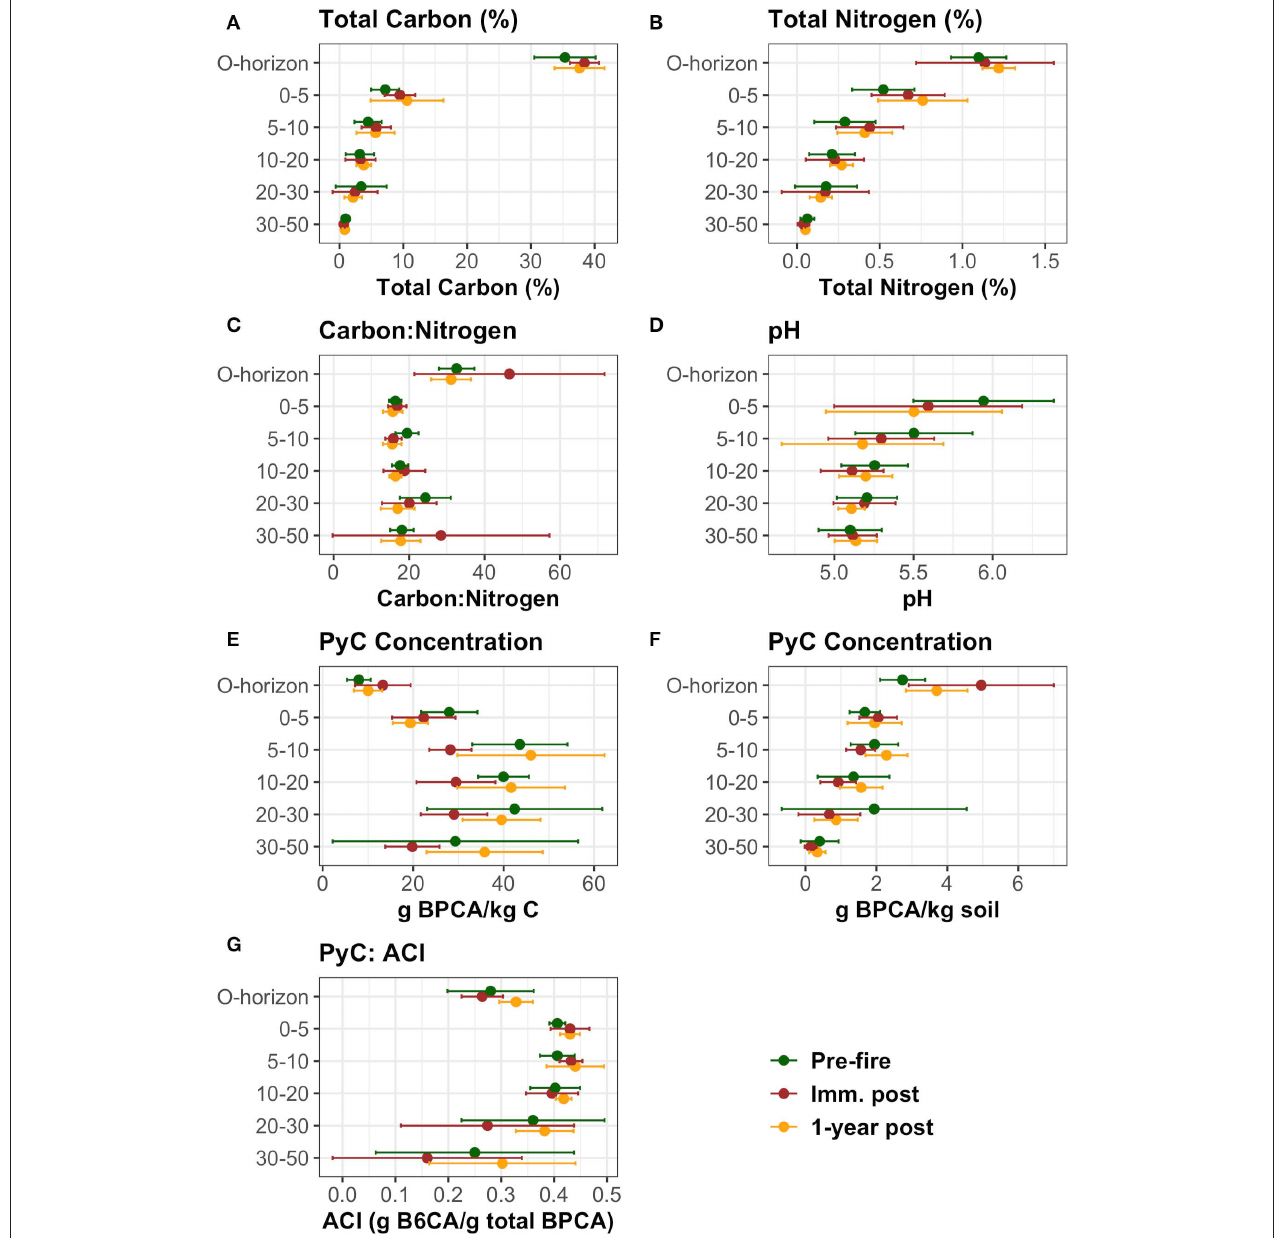
FIGURE 3 | (A) Total carbon, (B) total nitrogen, (C) C:N, (D) pH, (E) PyC concentration normalized by total carbon, (F) PyC concentration normalized by soil mass, and (G) ACI for core samples collected from the soil array that burned with low severity during the Chimney Tops 2 Fire. Circles denote mean values, error bars denote standard